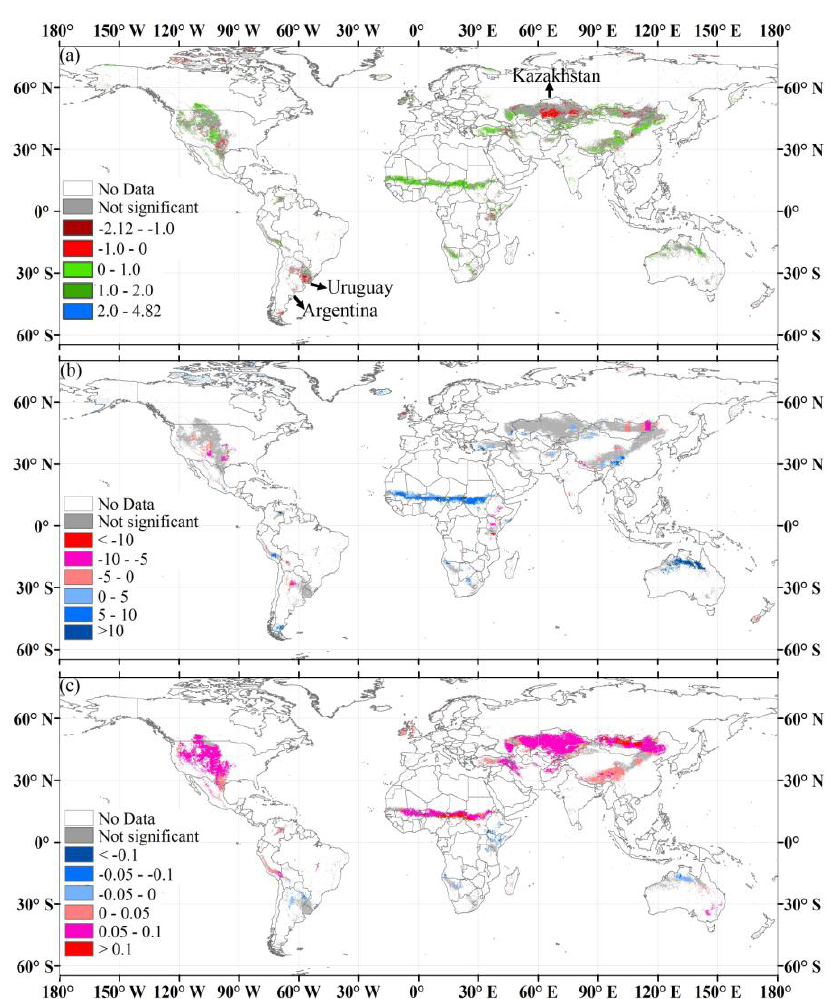
Figure 5. Spatial patterns of trends of aboveground biomass carbon density (( a ), gC·m −2 ·year −1 ), annual precipitation (( b ), mm·year −1 ) and mean temperature (( c ),°C·year −1 ) from 1982 to